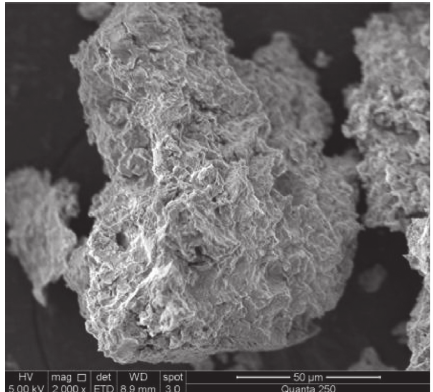
Figure 3: SEM image of the ZnO/sepiolite composite prepared by the sol-gel method.